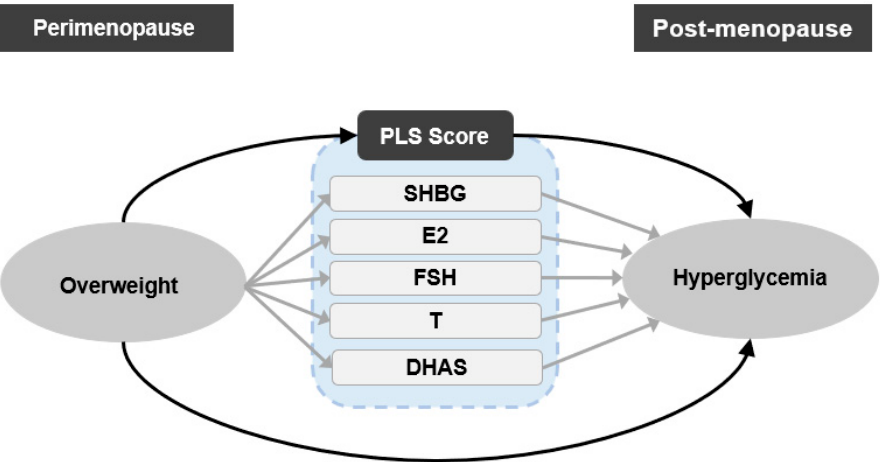
Figure 1. Scheme of the study design. Single-headed arrows represent regression paths; ovals represent exposure and outcome variables, and rounded rectangles represent mediator variables. PLS, partial least squares; SHBG, sex hormone binding protein; E2, estradiol; T, testosterone; FSH, follicle stimulating hormone; DHAS, Dehydroepiandrosterone sulfate.